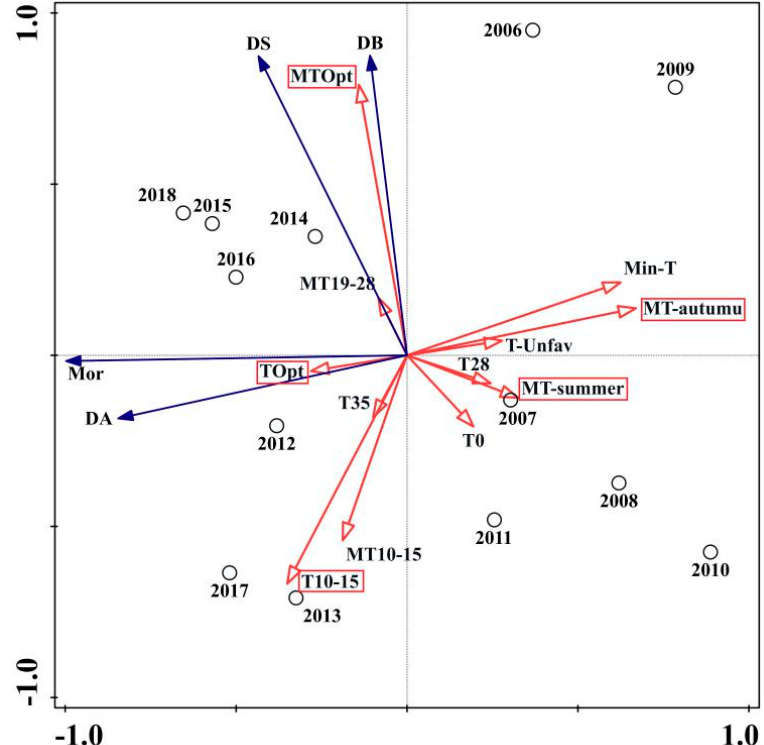
Figure 3. Results of the RDA ordination biplot presenting PWD variables and 12 selective temperature variables from 2006 to 2018. For PWD epidemic variables (filled arrows): Mor = The quantity of Masson pine mortality; DA = PWD damaged area; DB = The quantity of PWD damaged blocks; DS = The quantity of PWD damaged sites. For temperature variables (open arrows): MT autumu = Mean temperature in the autumn quarter (9–11); MT summer = Mean temperature in the summer quarter (6–8); MT Opt = Mean temperature of days with optimum temperature; T 10–15 = Number of days with a temperature between 10–15 °C from October to December; T Opt = Number of days with optimum temperature; T 35 = Number of days with temperature above 35 °C; MT 19–28 = Mean temperature of days with temperature between 19–28 °C from June to September; T 0 = Number of days with minimum temperature at or below 0 °C; Min-T = Minimum temperature during PWD life cycle; T Unfav = Number of days with unfavorable temperature; T 28 = Number of days with temperature above 28 °C; MT 10–15 = Mean temperature of days with temperature between 10–15 °C from October to December. Table 3. The selected climate and weather variables obtained from the summary of forward selection in the redundancy analysis.